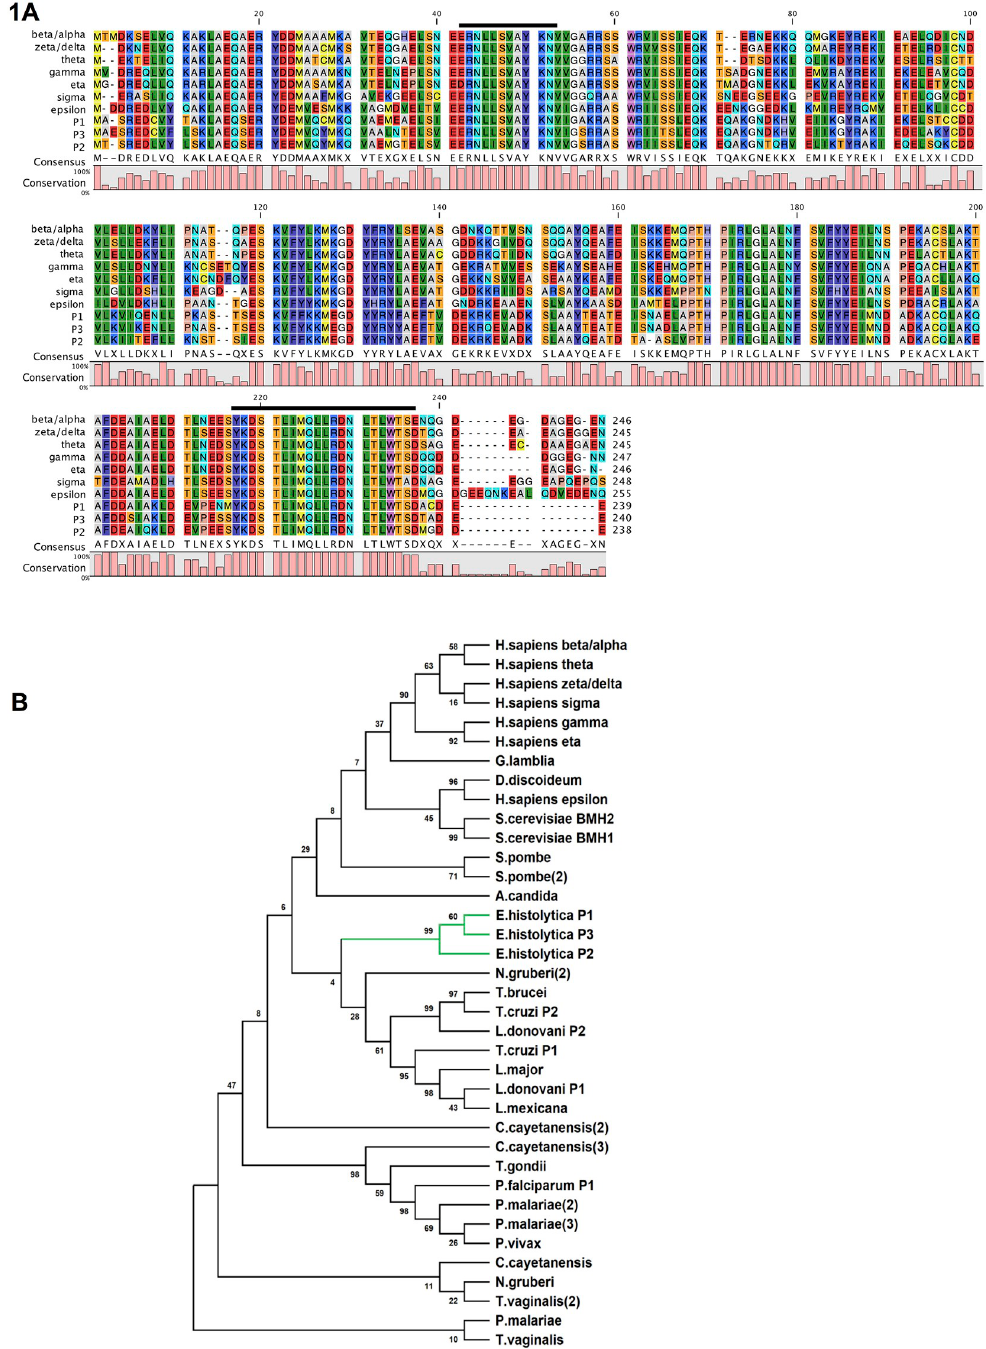
Fig 1. 14-3-3 family members and their phylogenetic analysis. (A) Sequence alignment of Eh14-3-3 proteins. The full- length Eh14-3-3 protein sequences (EhP1, EhP2, EhP3) has been aligned with the seven human 14-3-3 isoforms (h14-3- 3beta/alpha, h14-3-3theta, h14-3-3gamma, h14-3-3zeta/delta, h14-3-3eta, h14-3-3sigma, h14-3-3epsilon) using Clustal X (V2.1) and CLC sequence viewer (v6.3). Conserved residues are indicated as % conservation bar (0–100%) below the aligned sequences. Residues representing 14-3-3 protein signatures 1 and 2 are indicated by dark black lines. (B) Phylogenetic analysis of EhP3 proteins. Phylogenetic tree was constructed using an iterative neighbor-joining algorithm of MEGA 7.0 software. Bootstrap values (as percentages) are shown at each